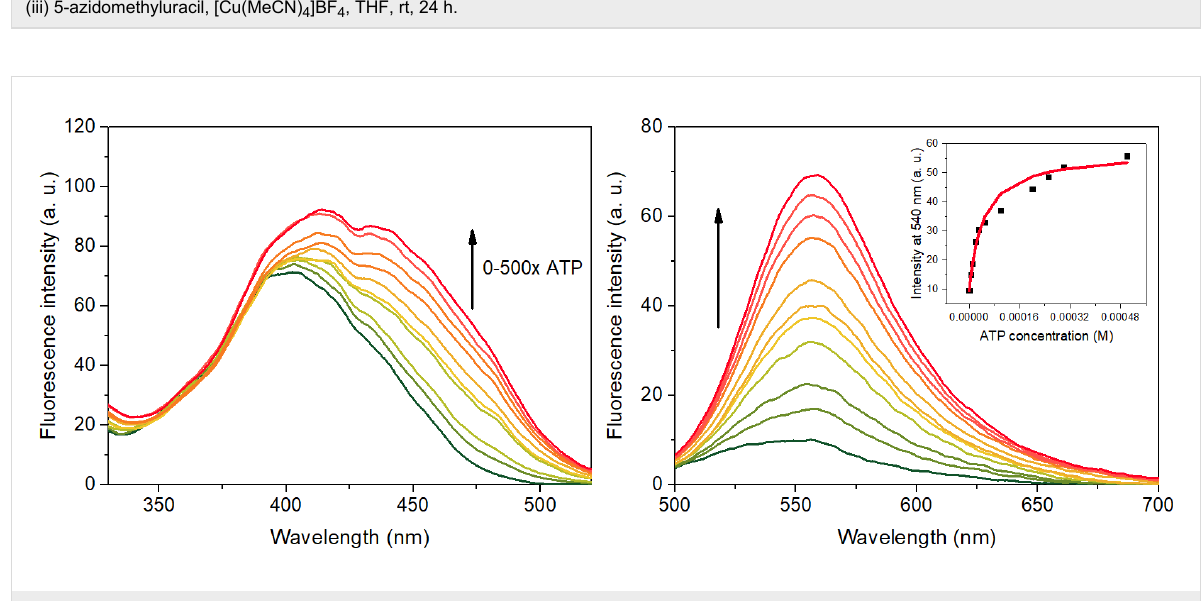
Figure 3: Variation of fluorescence spectra of UHF (1.0 μ M) upon addition of increasing amounts of ATP in 0.02 M HEPES buffer which also contains 0.1 mM γ -cyclodextrin. Left: excitation spectra, detection wavelength: 540 nm; right: emission spectra, excitation wavelength: 470 nm. The inset shows the emission at 540 nm as a function of the ATP concentration, whereas the curve represents the result of a non-linear fitting to the